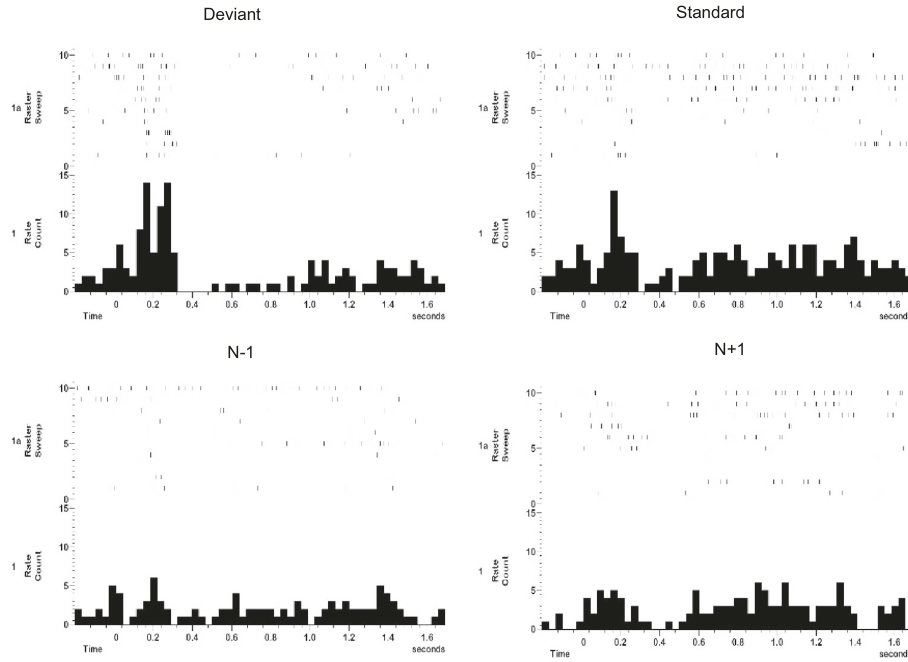
Fig. 4 Variable phasic cue responses to standard and deviant tones of the auditory oddball task. A phasic as well as tonic response was observed in some thalamic neurons. In this example, a phasic response is present in response to the deviant ( “ N ” ) ( upper left ) and in the fi rst and last fi ve standard tones ( upper right ). A tonic inhibitory response was more prominent for the deviant tone. Histograms in lower panel show averages of all the standard tones just before ( N − 1) and just after ( N + 1) the deviant tone and no phasic response was